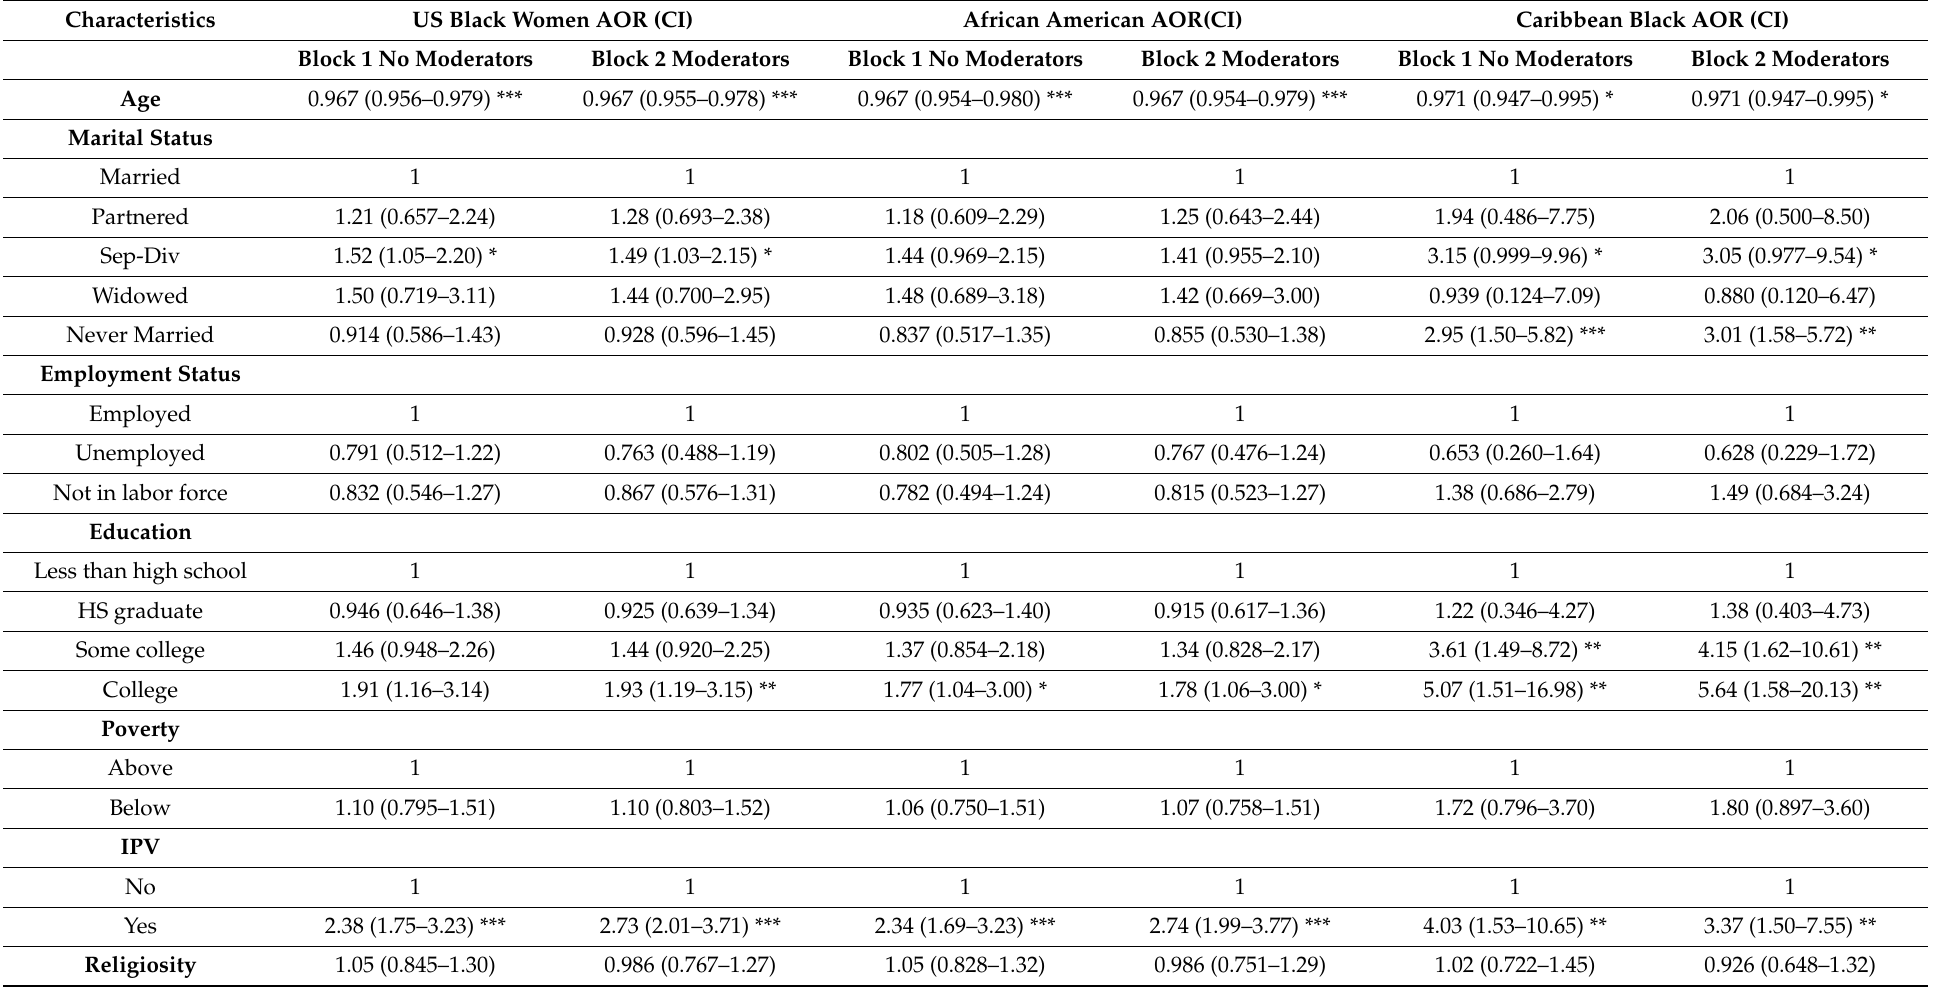
Table 2. Multivariate Analysis Examining IPV and Moderators on Mood